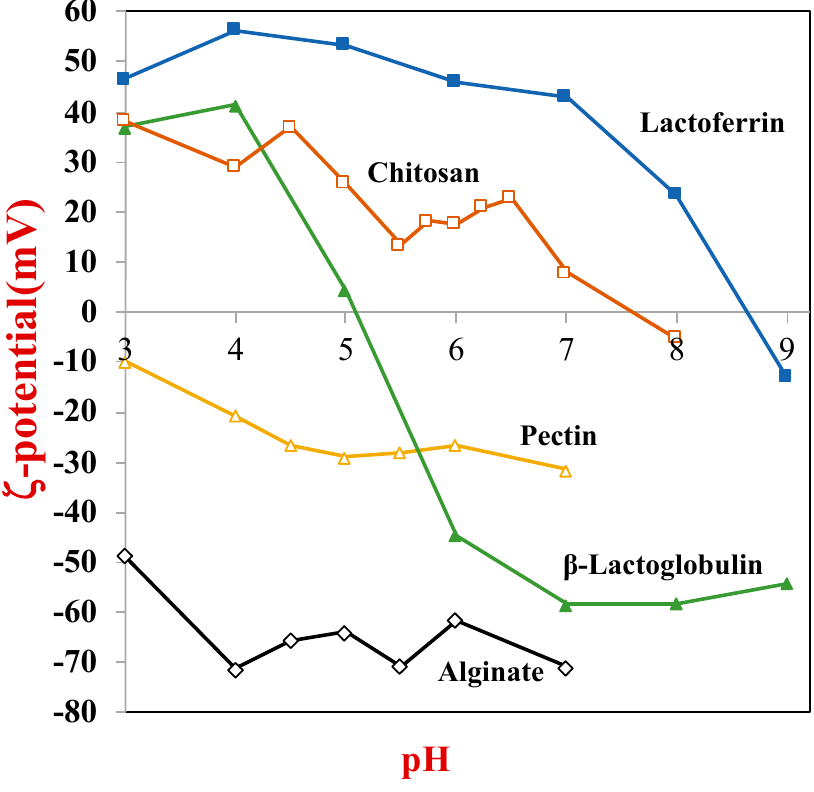
Figure 2. The electrical potential of biopolymers, such as proteins and polysaccharides, changes appreciably with pH due to ionization/deionization of charged groups.